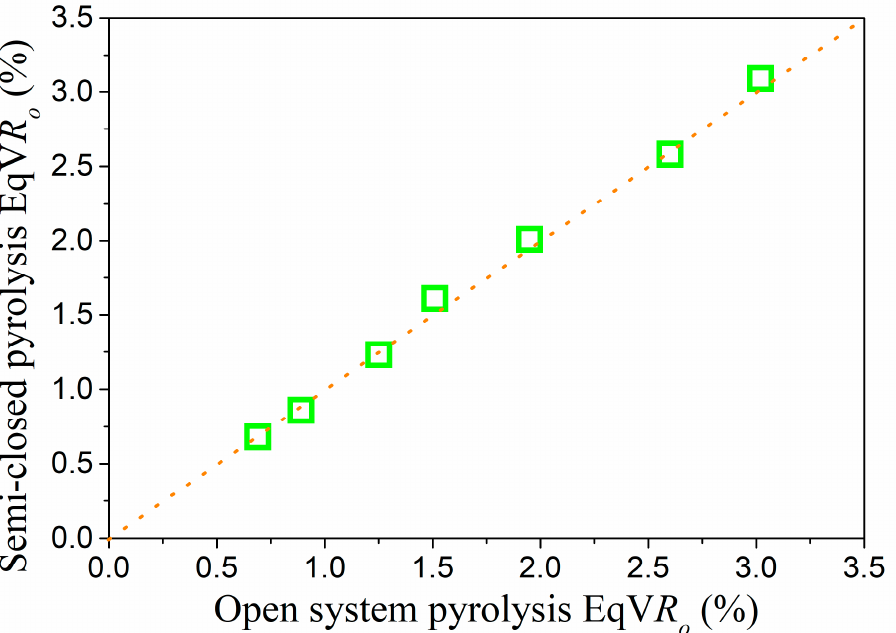
Figure 3. Comparison of shale thermal maturity based on open and semi-closed system pyrolysis experiment. Data of semi-closed pyrolysis are cited from Fang et al. [21].